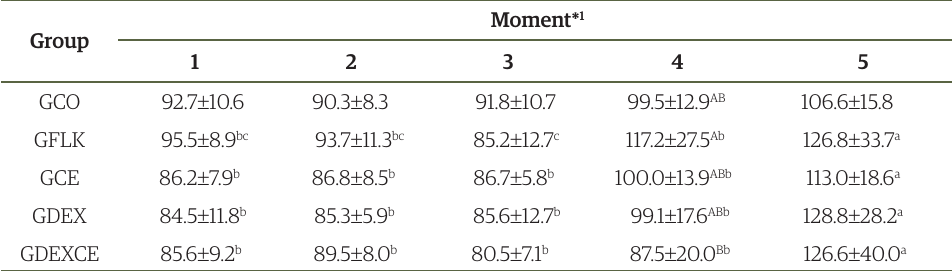
Table 7. Blood glucose values (mg/dL) between moments in the groups.